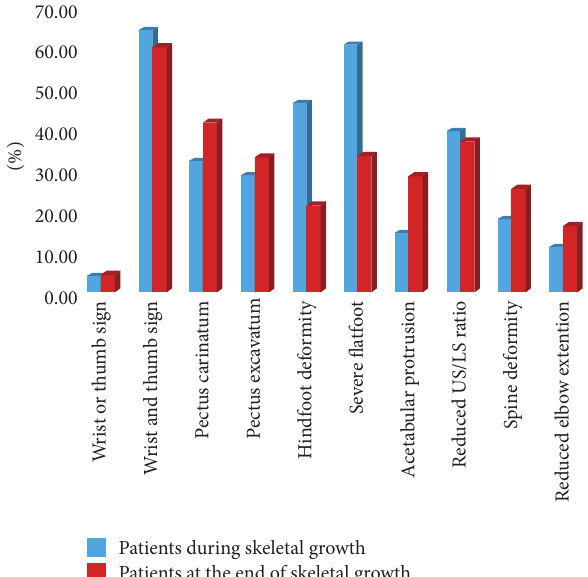
Figure 6: The histogram shows the prevalence of skeletal deformi- ties in 146 patients affected by Marfan syndrome before and after the end of skeletal